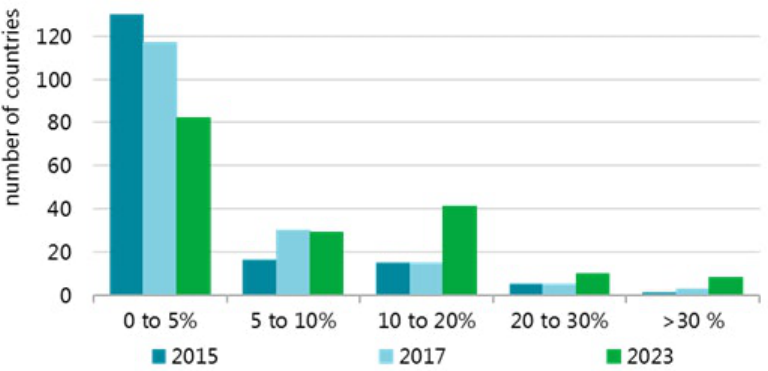
Figure 2. Trend of VRE penetration up to 2023 [3]. Source: IEA (2019). Status of Power System Transformation 2019. All rights